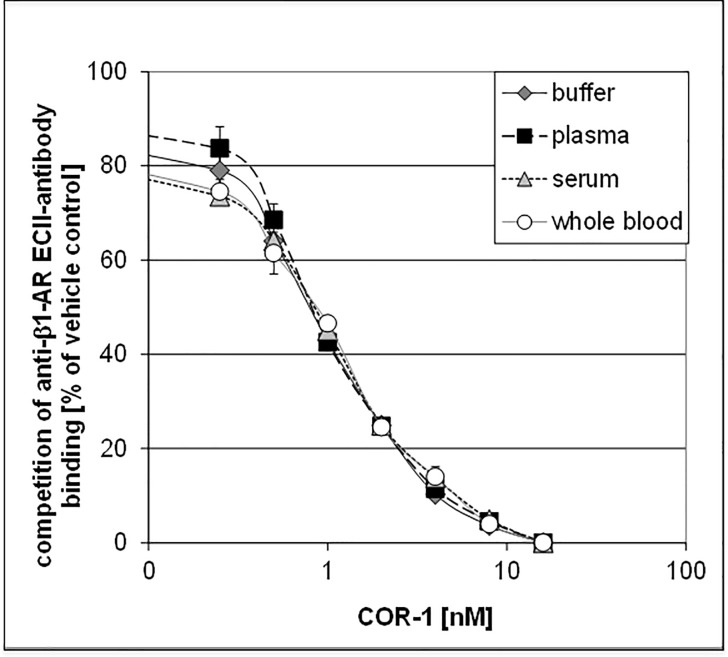
ELISA: Inhibition of anti-ß1EC2–antibody binding to coated 25-meric ß1EC2 peptides in the presence of increasing concentrations of COR-1, on a background of either 25% saline or rat serum, rat plasma or rat whole blood.